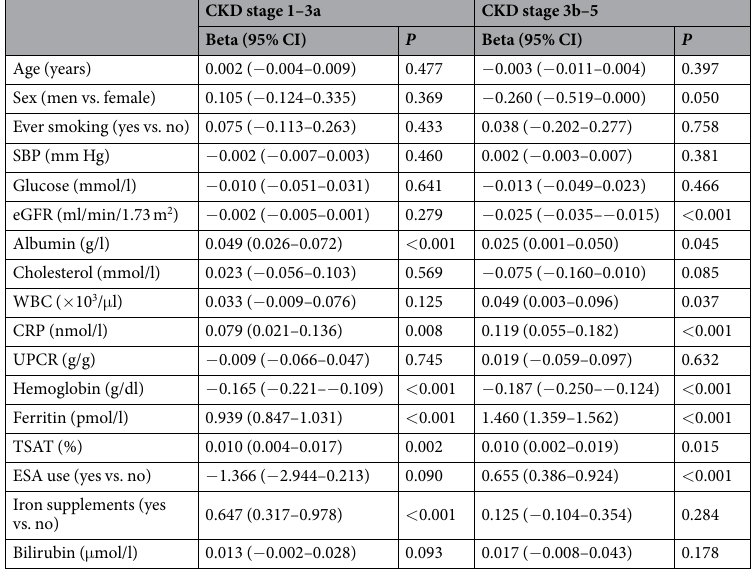
Table 4. Subgroup analysis for square root of serum hepcidin level according to CKD stages in multivariable linear regression analysis. SBP, systolic blood pressure; eGFR, estimated glomerular filtration rate; WBC, white blood cells; CRP, C-reactive protein; UPCR, urine protein-to-creatinine ratio; TSAT, transferrin saturation; ESA, erythropoiesis stimulating agents. Logarithmic transformations were done for CRP, UPCR and ferritin. Variables with P < 0.05 in univariable linear regression analysis were chosen as covariates in multivariable linear regression